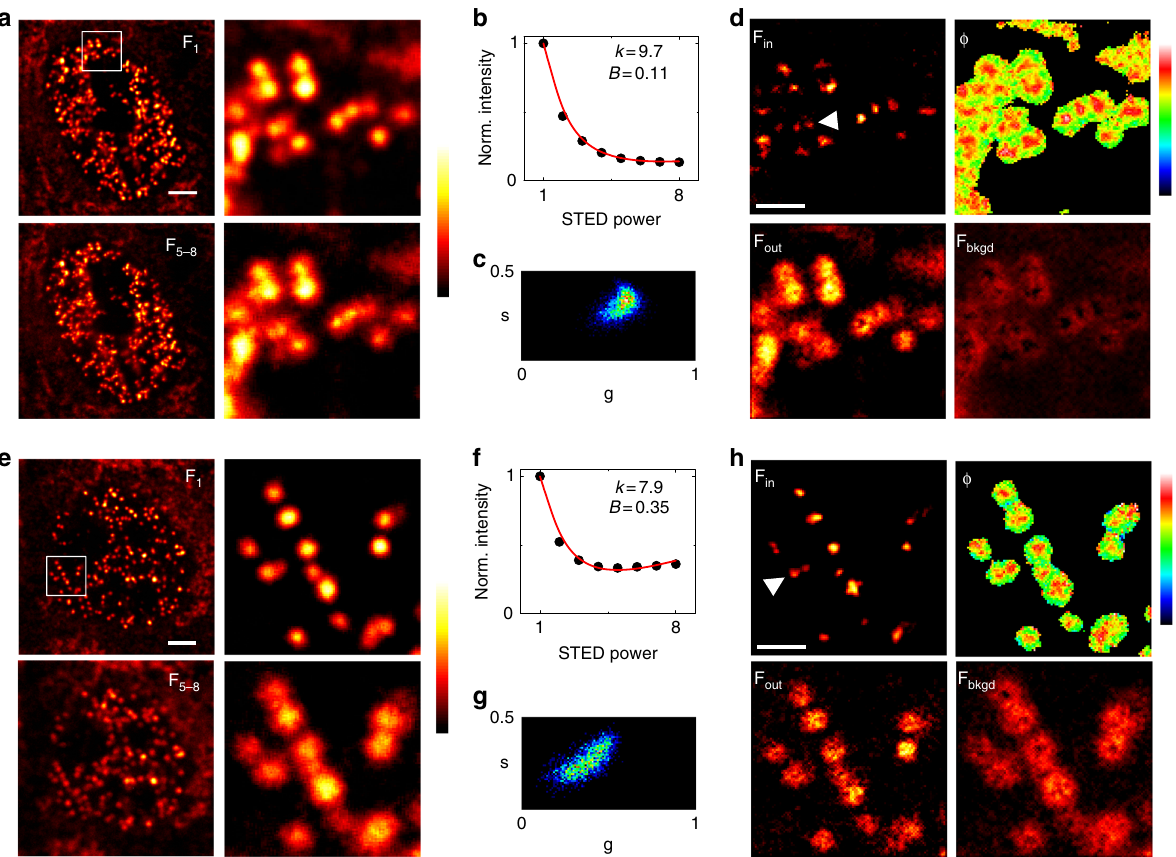
Fig. 5 M-STED of replication foci in MCF10A nuclei. a , e Examples of acquired stack images, from the confocal F 1 to maximum STED power F 8 ( P max = 19 mW). Depicted is the sum of the last four frames F 5 – 8 . Color scale: normalized intensity. Scale bars: 3 µ m. b , f Average variation of the fl uorescence intensity as a function of the STED power, together with the respective k and B values retrieved from the fi tting of Eq. (6) to the data. c , g Phasor plot of the data shown in a and e , respectively. d , h SPLIT image components F in , F out , and F bkgd , and the corresponding phase image ϕ . The white arrowheads point at pairs of foci that are better resolved in the SPLIT images. Color scale: phase ϕ (0 – 0.75). Scale bars: 1 µ